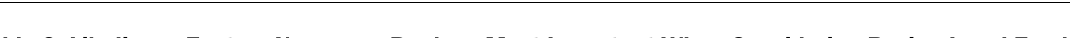
Table 9. Likeliness Factors Non-users Rank as Most Important When Considering Buying Local Foods Variable I would be more likely to purchase and use local foods